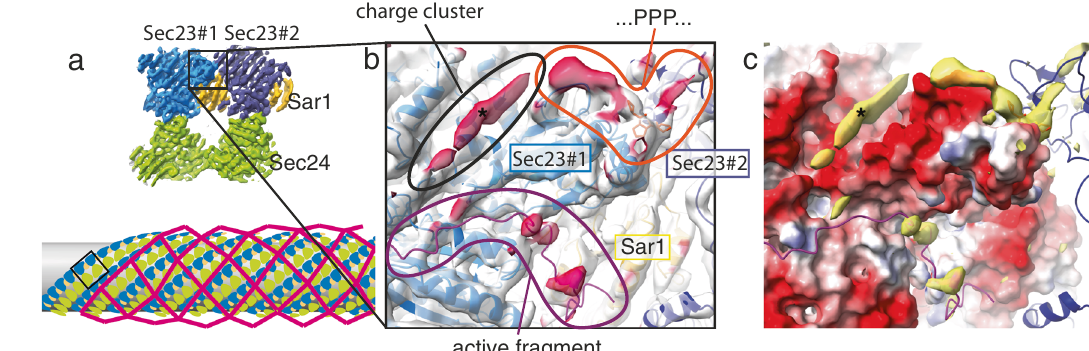
Fig. 5 Inner-outer coat interactions. a Top: the inner coat lattice structure, with a box indicating the region represented in ( b , c ). Bottom: schematic representation of coat architecture, with inner coat highlighted in the box. b The density-modi fi ed inner coat subtomogram average and the re fi ned model. The map is coloured in transparent white, while regions that are further than 3 Å from the model are coloured in dark red, indicating density that is not explained by the model and is attributed to outer coat binding. Sigma threshold for contouring was set at 0.08. c The difference map between the map and a model-generated density ( fi ltered at 4 Å, yellow) is overlaid to the model surface coloured according to its Coulombic potential. The outer coat density indicated by the asterisk binds to a negatively charged groove on